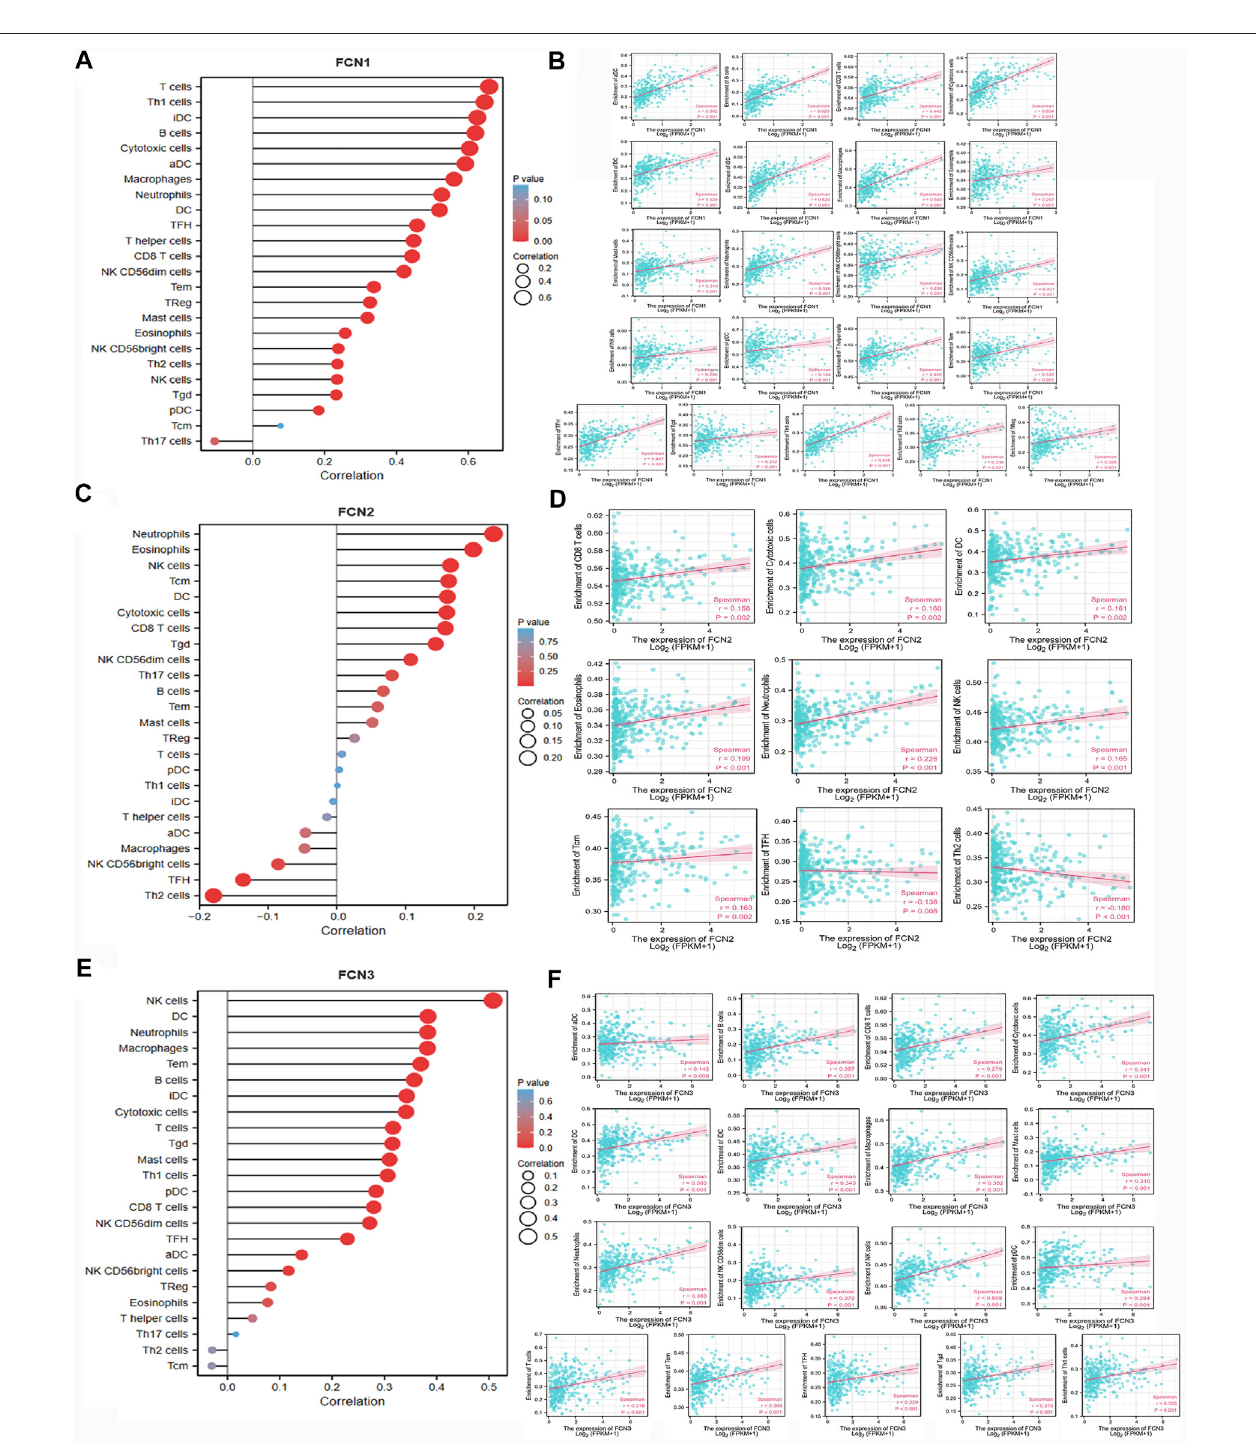
FIGURE 7 | Correlation between FCNs and immune cell in fi ltration. (A,B) FCN1; (C,D) FCN2; (E,F) FCN3.